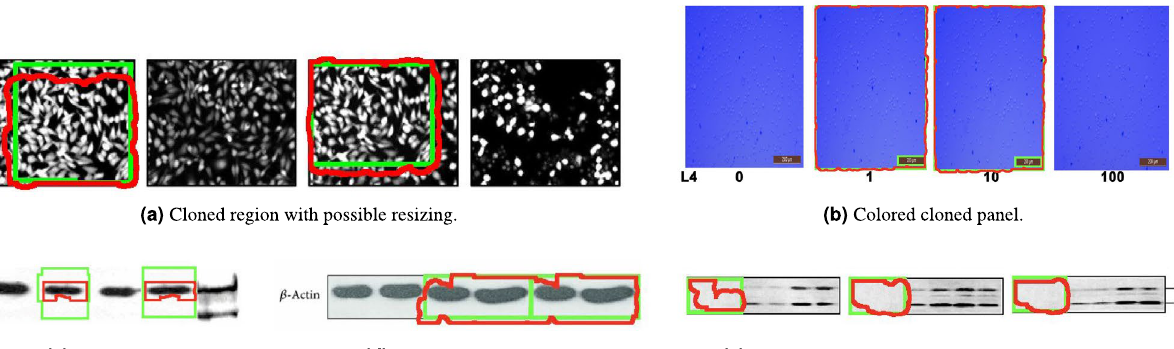
Figure 5. Results of copy-move detection that agree with existing retraction notices. In green boxes, the manual annotations provided as ground truth within the herein introduced SP dataset. In red, the cloned regions identified by SILA. The system correctly identifies cloned image regions in different scenarios. In ( a ), microscopy images of incubated cells. In ( b ), cell cultures that were captured by an inverted microscope. In ( c – e ), western blots. When SILA points out a cloned region, it does not necessarily mean a mistake or misconduct. All original images within this figure belong to papers published as Creative Commons content. The respective sources are available through DOI https:// doi. org/ 10. 1074/ jbc. M109. 090209, https:// doi. org/ 10. 1371/ journ al. pone. 00858 08, https:// doi. org/ 10. 1186/ 1471- 2180-6- 26, https:// doi. org/ 10. 1155/ 2014/ 987017, and https:// doi.